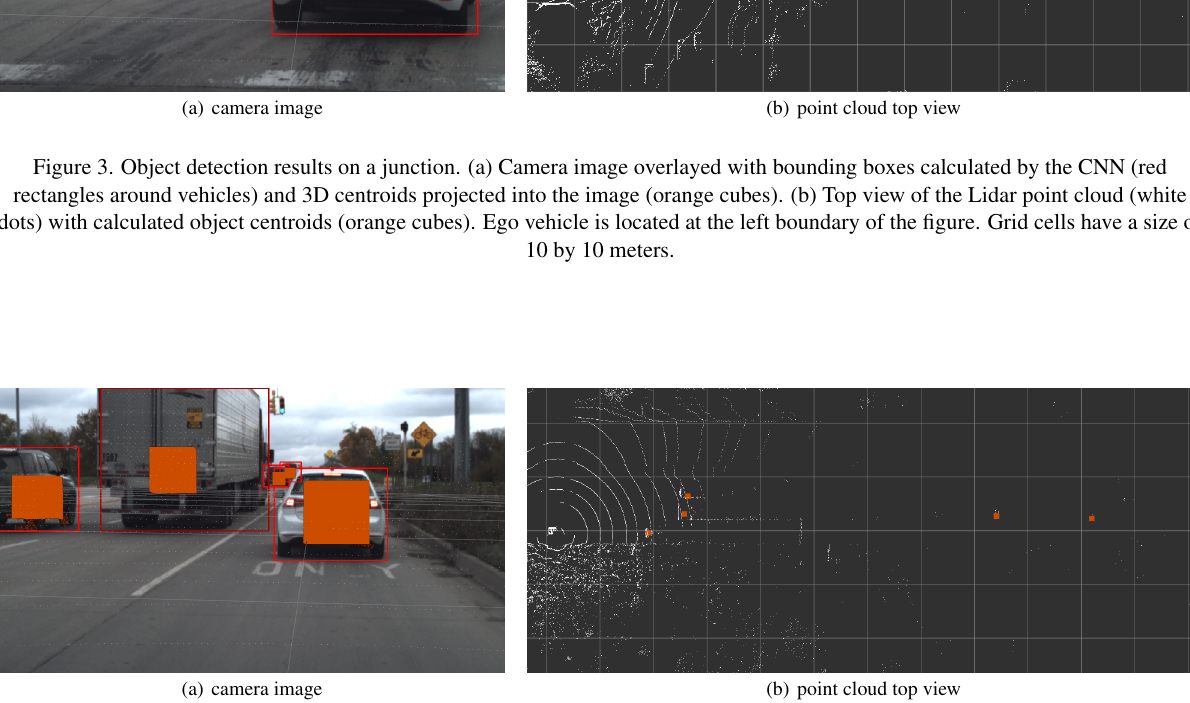
Figure 4. Object detection results in heavy traffic. (a) Camera image overlayed with bounding boxes calculated by the CNN (red rectangles around vehicles) and 3D centroids projected into the image (orange cubes). (b) Top view of the Lidar point cloud (white dots) with calculated object centroids (orange cubes). Ego vehicle is located at the left boundary of the figure. Grid cells have a size of 10 by 10 meters. Even the two cars between the truck and the leading vehicle in a distance of about 80 m and 100 m are detected